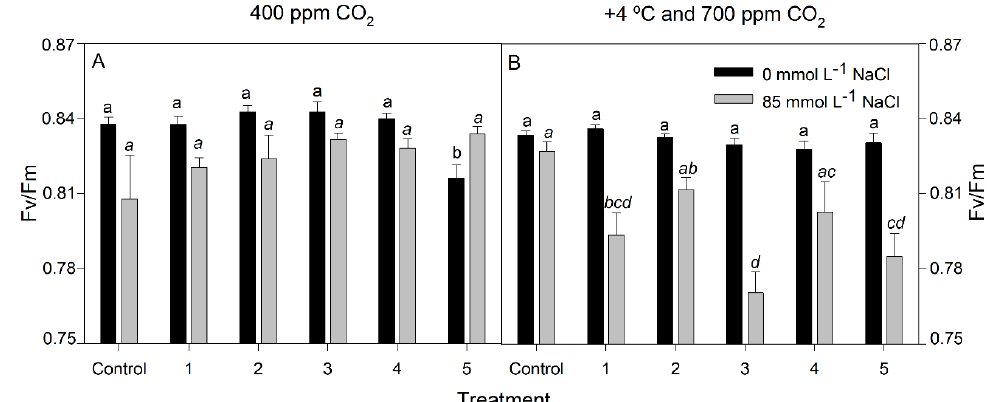
Figure 4. Maximum quantum efficiency of PSII photochemistry (Fv/Fm) of strawberry plants inoculated with rhizobacteria consortia, numbered 1 to 5 (control = non-inoculated plants), after 30 d of treatment at 400 ppm CO 2 ( A ) and at +4 °C and 700 ppm CO 2 ( B ) with 0 and 85 mmol L − 1 NaCl. Each value represents the mean of eight replicates ± SE. Different letters for each saline treatment (capital and italic letters for 0 and 85 mmol L − 1 NaCl, respectively) indicate those means that are significantly different from each other (GLM; Duncan test, p < 0.05).